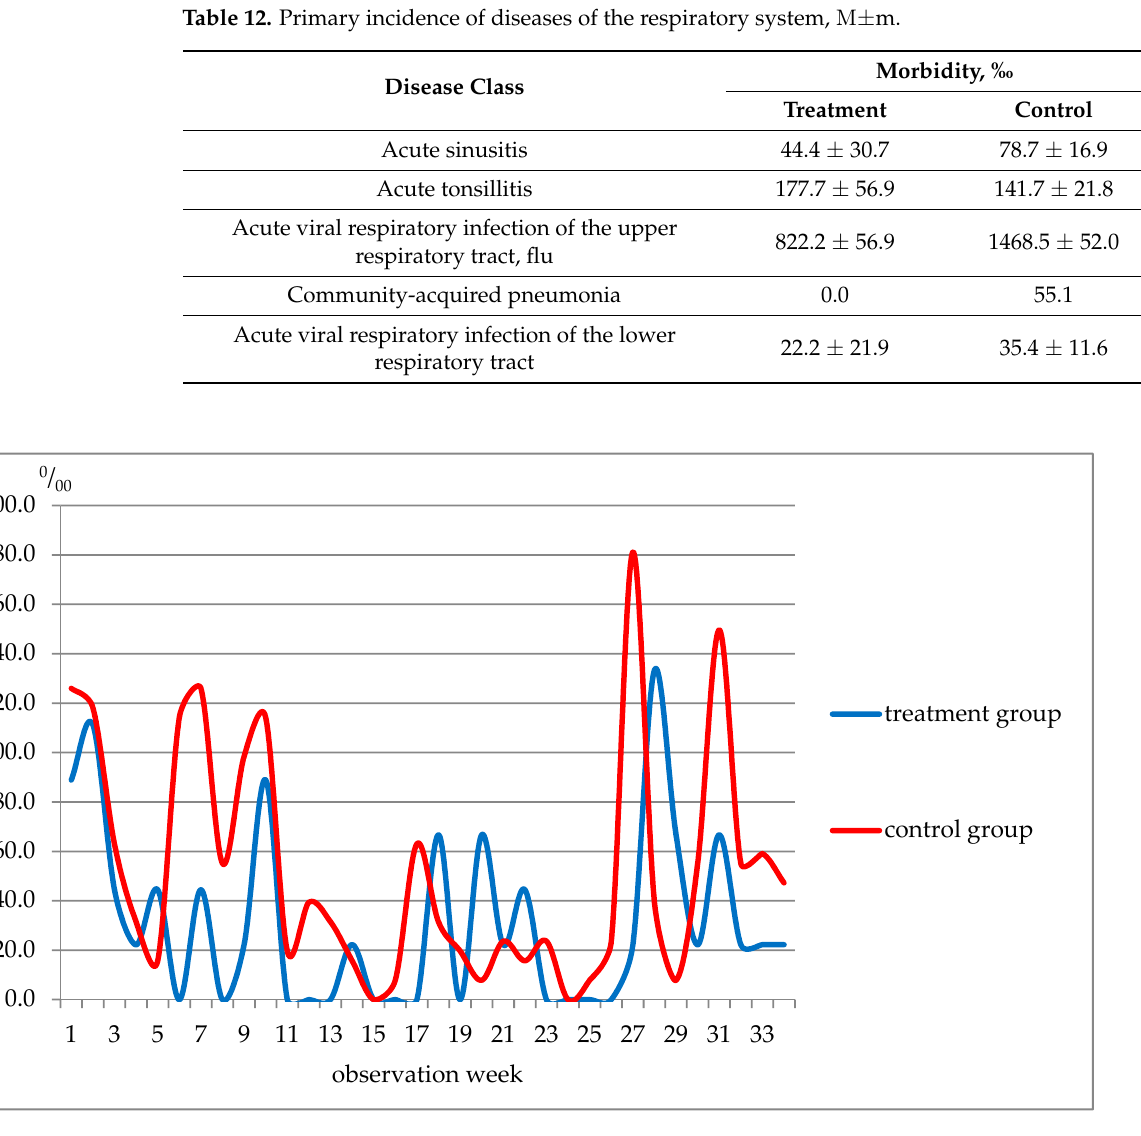
Figure 1. Weekly morbidity in students (respiratory system diseases), ‰ . The data in Table 13 show that, although the incidence of respiratory diseases in the control group was slightly higher before and during the treatment period (weeks 1–5), the incidence of acute viral respiratory infections of the upper respiratory tract (ARI URT) and flu was almost the same in the two groups. Further, in weeks 6–10, these indicators in the treatment group were lower than in the control group, 3.3 times and 5.6 times, respectively. In weeks 11–19 of the observation, the incidence of respiratory diseases in the treatment group was 2.6 times lower and in weeks 23–27, there was a 10.6-fold decrease in the disease incidence rate. Such a shift was not noted for acute respiratory diseases and flu. It was not earlier than weeks 28–34 when the incidence of ARI, upper respiratory tract infection and influenza began to approach that in the control group (Figure 2). Table 13. Morbidity patterns in the control group by the most prevalent disease classes,%, rank. Week of Observation